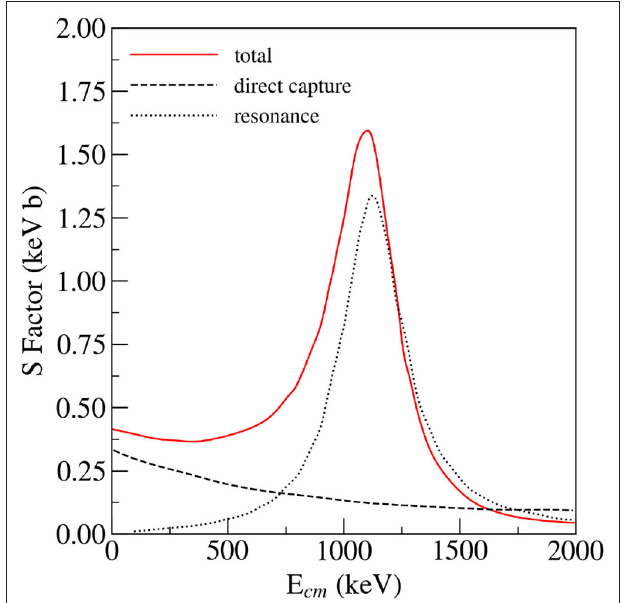
FIGURE 13 | The astrophysical S-factor for the 12 N(p, γ ) 13 O capture as a function of the energy. The solid red line shows results for the total S-factor, dashed line is the direct component of the S-factor and the dotted line is the resonant component.